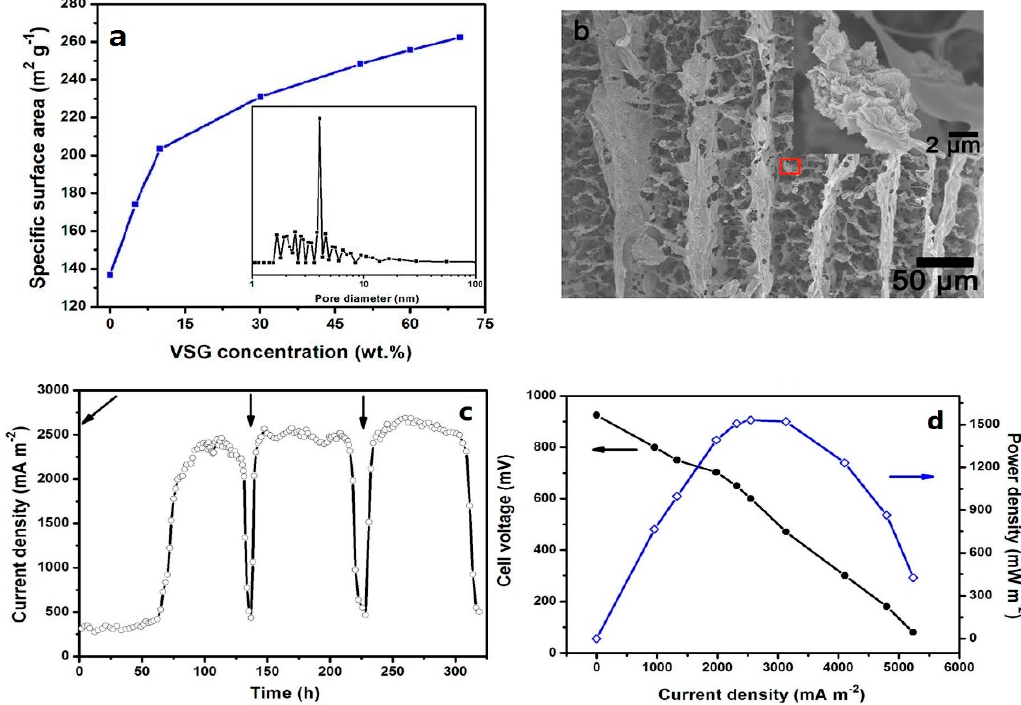
Figure 6. ( a ) The plot of the specific surface area increasing with the vacuum-stripped graphene concentration of the chitosan/vacuum-stripped graphene (CHI/VSG) scaffolds; ( b ) CHI/VSG-50 scaffold; Constant-load discharge curve ( c ); and power density and polarization curves ( d ) of the microbial fuel cells based on the CHI/VSG-50 anode. Arrows of ( c ) indicate the time of glucose feeding. Adapted from [68], with permission from © 2012 American Chemical Society.